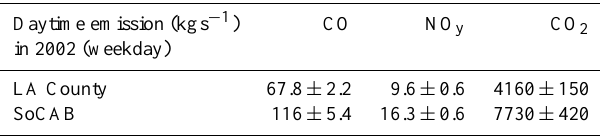
Table 5. Total daytime emissions of CO, NO y and CO 2 in Los An- geles County and the SoCAB during weekdays for the posteriors in 2002 from the inversion technique applied in this